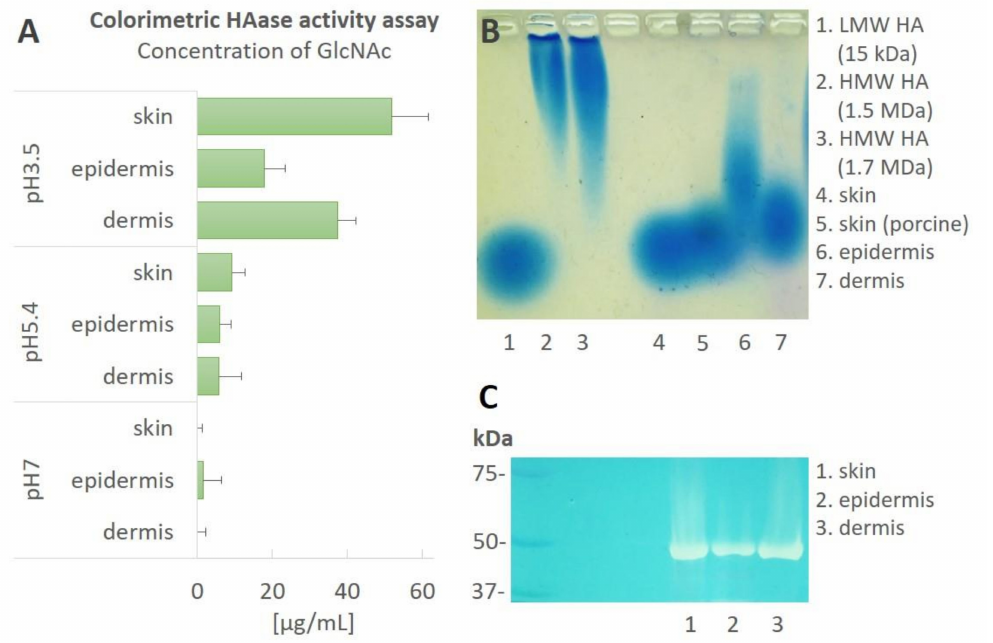
Figure 4. Hyaluronidase activity in the skin. Hyaluronidase activity was analyzed in the homogenates (10 mg proteins/mL) from the human skin, epidermis and dermis. ( A ) Colorimetric hyaluronidase activity assays of the samples incubated at differing pH values (pH 3.5, pH 5.4 and pH 7). The values represent the means of three independent biological samples ± the SEM of the GlcNAc concentrations. ( B ) HA size analysis via agarose gel electrophoresis at pH 3.5. The samples were incubated with exogenous HMW HA (1.5 MDa) at 37 ◦ C for 24 h. The samples were then analyzed via agarose gel electrophoresis and HA staining (blue). The LMW HA and both HMW HA served as the size references. ( C ) A representative zymography using HMW HA as a substrate. The left-most lane shows a protein ladder. Abbreviations: low molecular hyaluronan (LMW HA), high molecular hyaluronan (HMW HA), N-acetylglucosamine